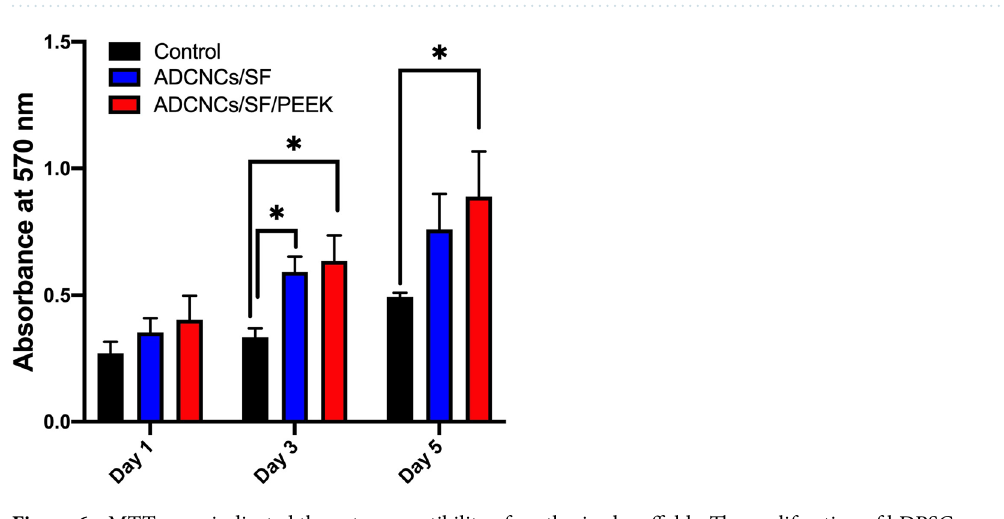
Figure 6. MTT assay indicated the cytocompatibility of synthesized scaffolds. The proliferation of hDPSCs seeded on hydrogels was increased over time. This proliferation were raised significantly on day 3 and 5 after seeding of stem cells on hydrogels. Control: DPSCs without facing hydrogels, ADCNCs/SF: DPSCS seeded on hydrogel without PEEK, ADCNCs/SF/PEEK: DPSCS seeded on hydrogel containing PEEK (* P <